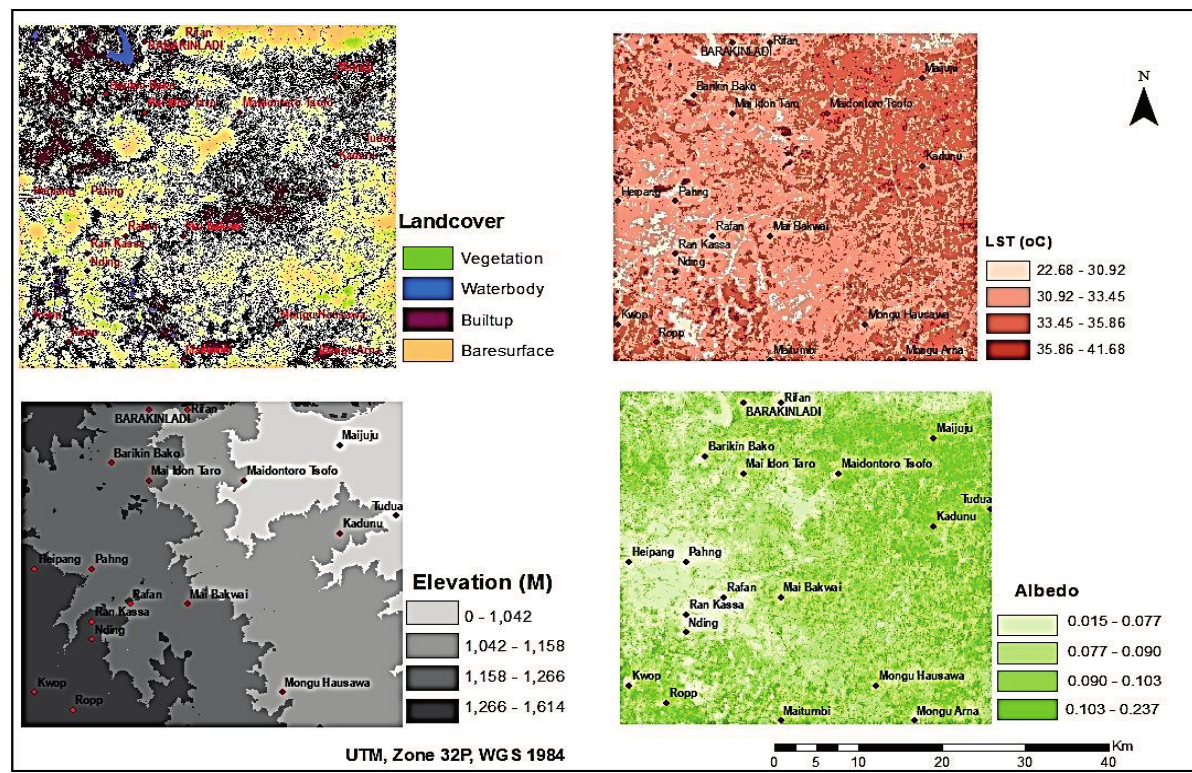
Figure 12. Landcover, LST, albedo and topography in Barakinladi in 2014.